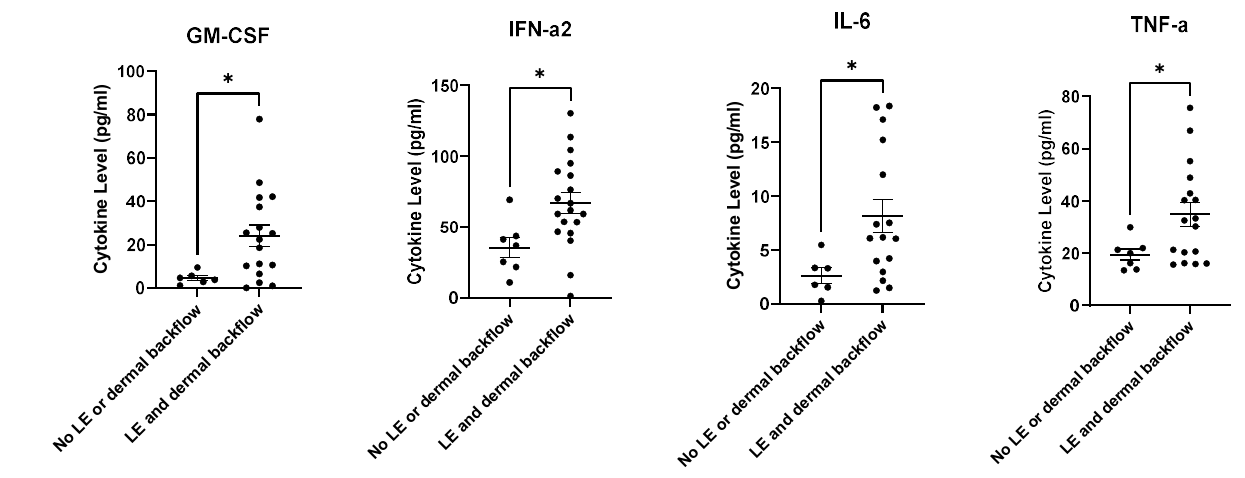
Figure 7. GM-CSF, IFN-α2, IL-12p40, IL-15, IL-6, TNF-α, and MIP-1β were significantly higher at pre-ALND in subjects with both clinical BCRL/LE and dermal backflow at 12-months post-RT com- pared to subjects with no clinical BCRL or dermal backflow. * p ≤ 0.05, ** p ≤ 0.01, *** p ≤ 0.001. 3.6. Several 12-Months Post-RT Cytokines/Chemokines Were Elevated in Subjects with Both Clinical BCRL and Dermal Backflow Compared to Subjects with Neither Clinical BCRL nor Der- mal Backflow IL-15, IL-3, and MIP-1β were found to be significantly higher in those who developed LE and dermal backflow at 12-months post-RT in comparison to those who did not de- velop LE or dermal backflow at 12-months post-RT (Figure 8). Other plasma cyto- kine/chemokine levels did not reach significance, but many trended upwards (Figure S5).